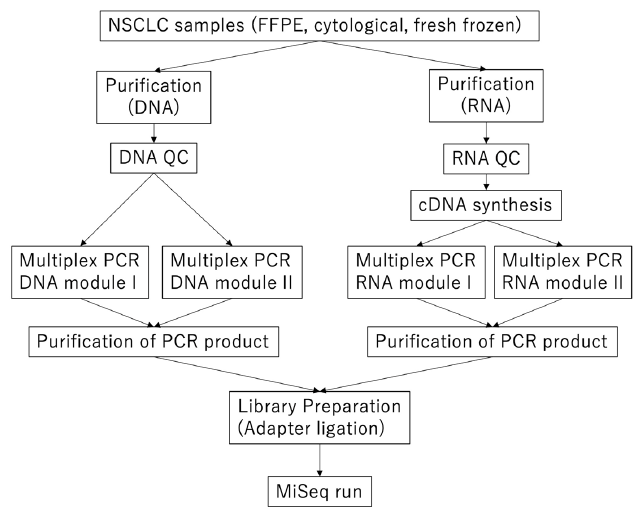
Figure 1. Flowchart depicting the analytical procedure.